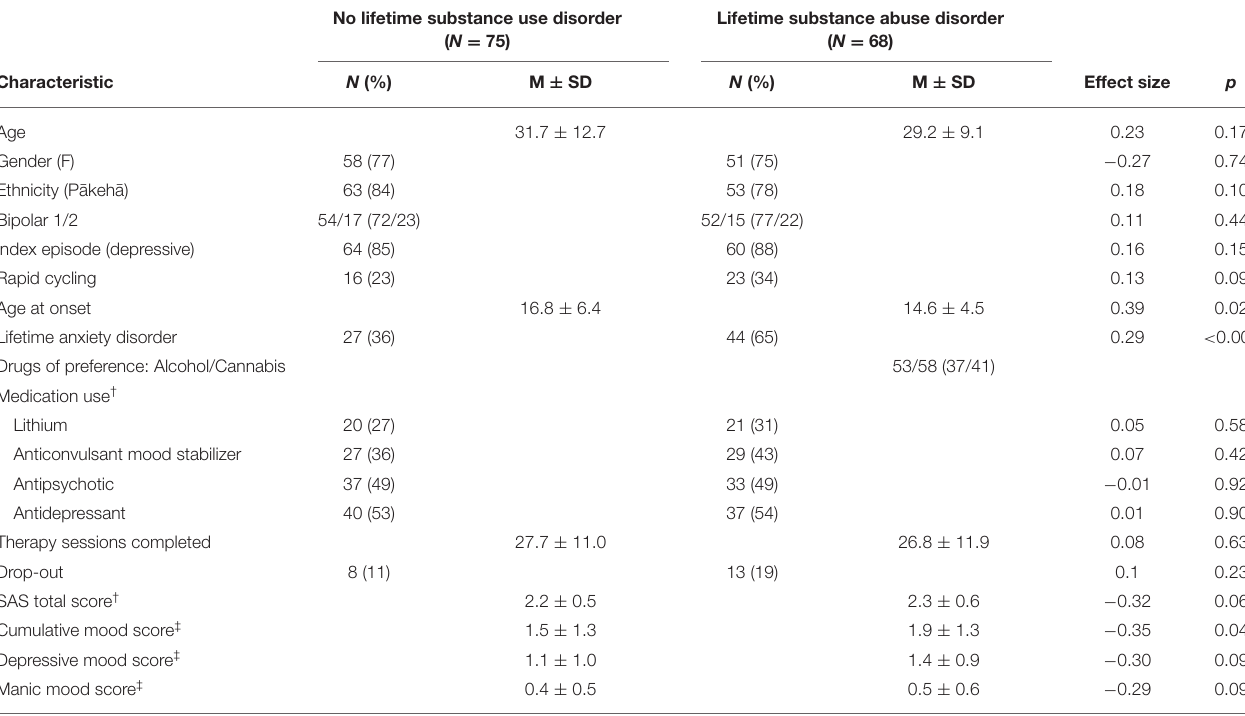
TABLE 1 | Clinical characteristics of lifetime SUD and non-SUD groups.